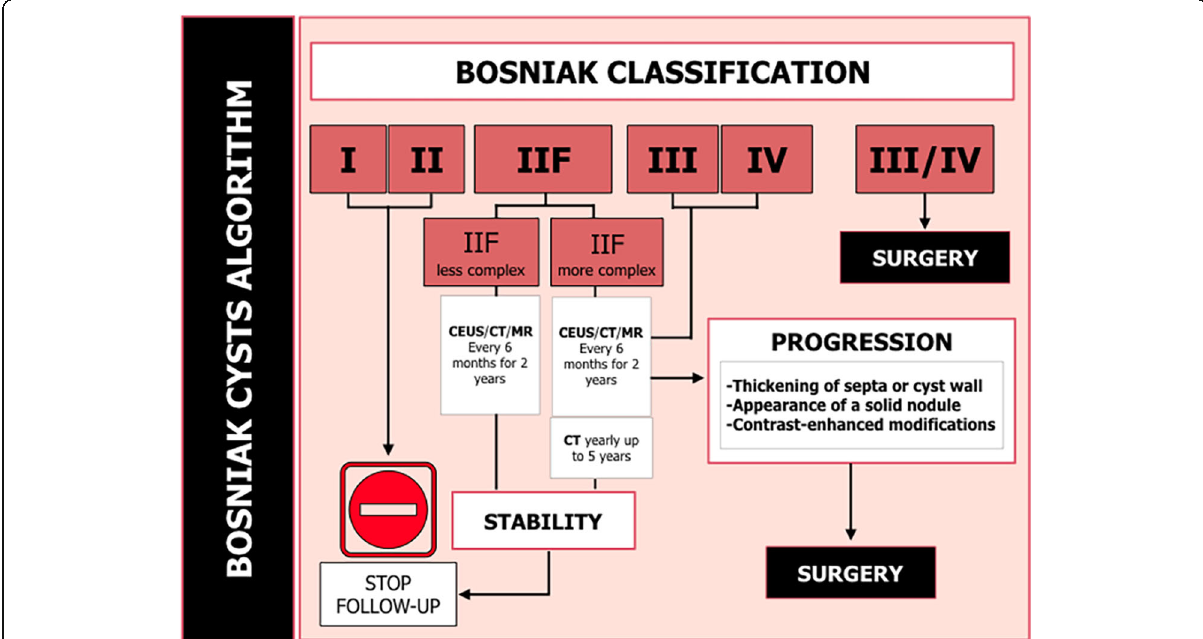
Fig. 17 Suggested Bosniak cyst classification management